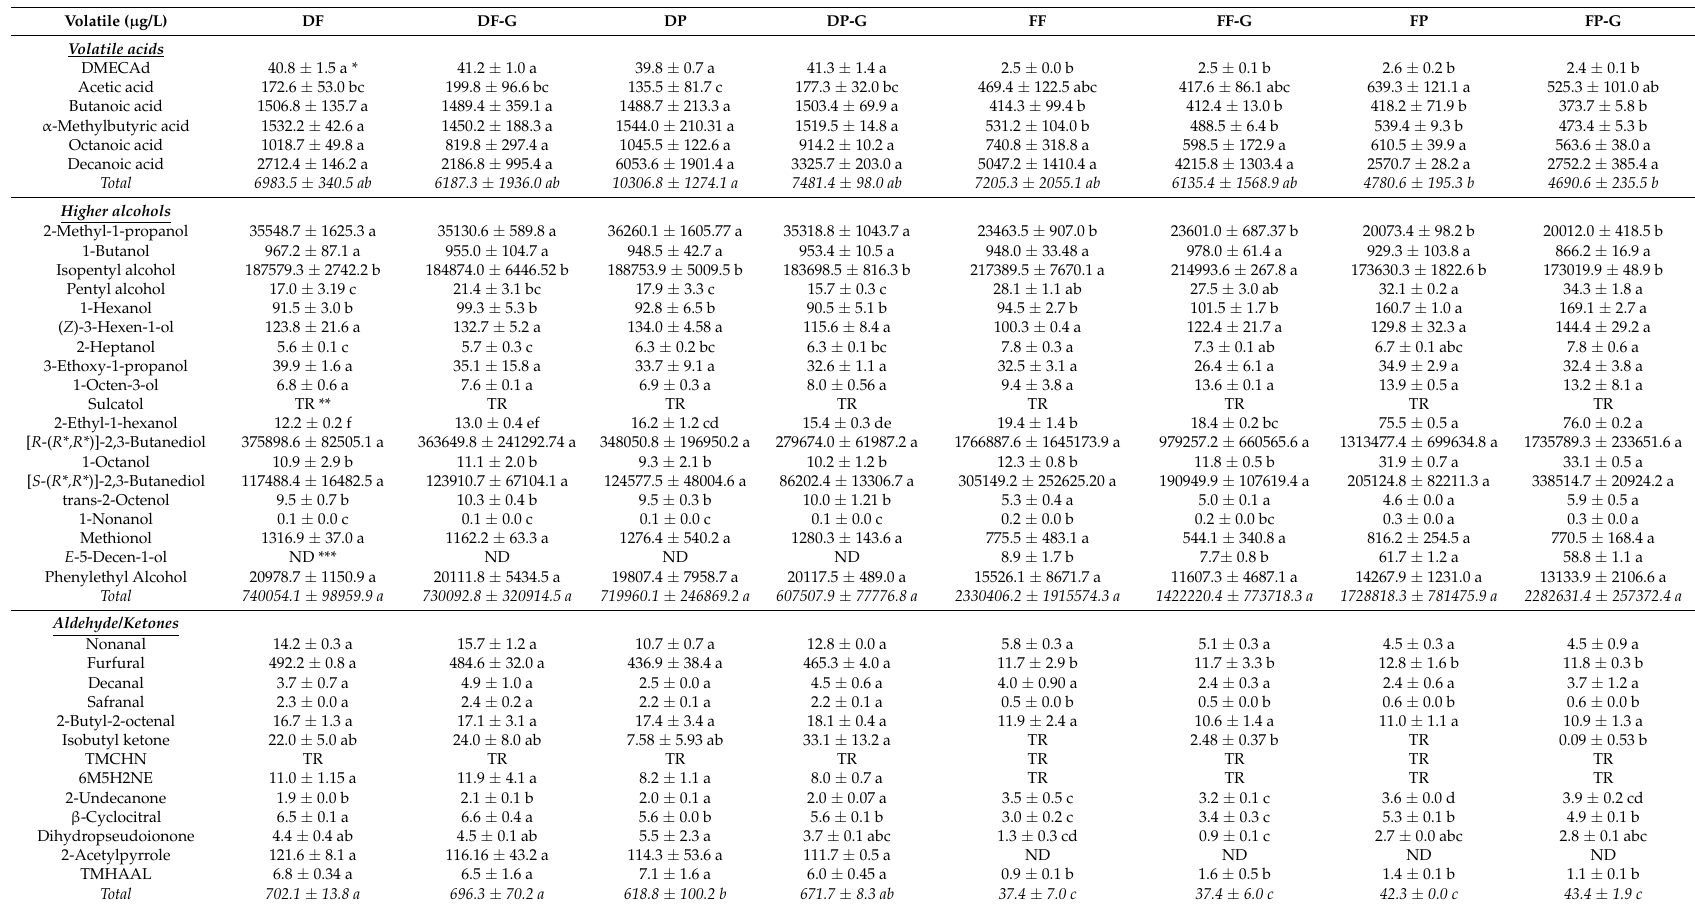
Table 3. Concentration of volatile compounds in goji berry fermented